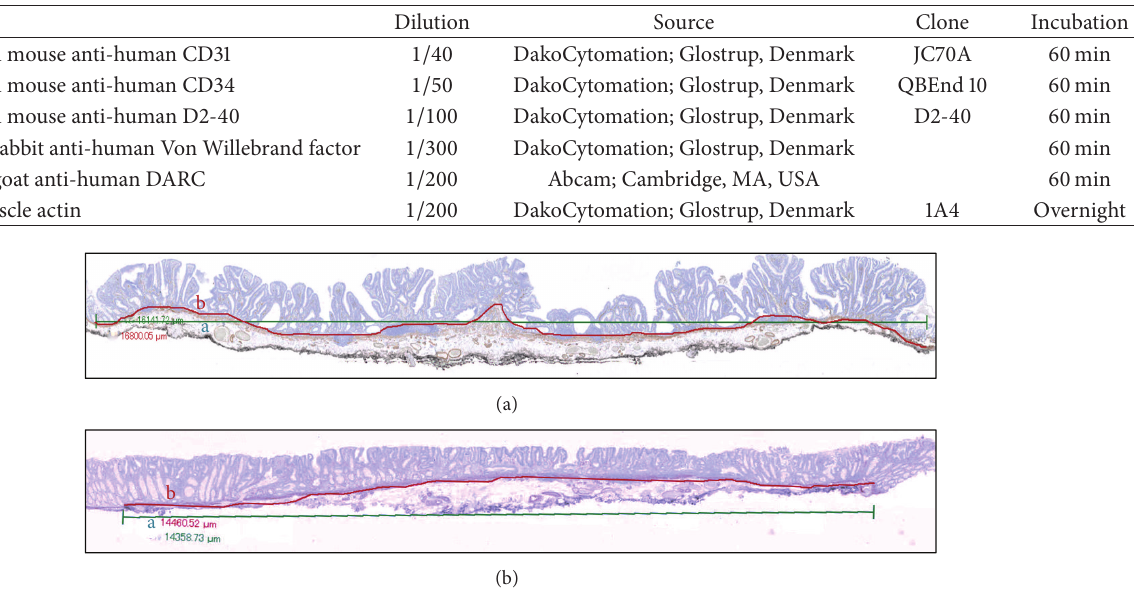
Figure 2: Analysis of the disposition of the muscularis mucosae of laterally spreading tumors (LST). The length of the lesion in a straight line (a: green line) and the length of the muscularis mucosa (MM) (b: red line) were measured digitally. (a) The irregular disposition of the MM of LST-granular type was reflected in greater ratios between both measures (b/a). (b) In contrast the MM of LST-NGs were flat as both lengths (a, b) were nearly similar.